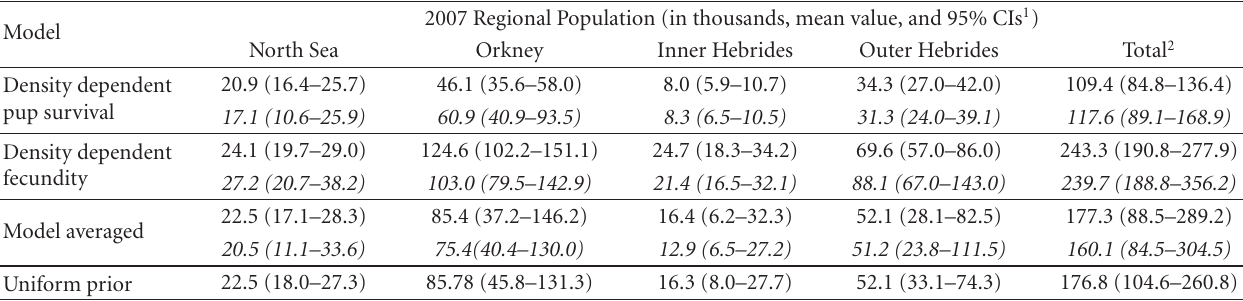
Table 2: Estimates (mean and 95% credibility intervals) of the total size of the grey seal populations in each region before breeding in 2007. The results for the two models are given along with those from simple (equally weighted) model averaging and applying the uniform prior across the two models. The numbers in italics are the equivalent estimates calculated from the best fitting state space models contained in the 2008 report of the UK Standing committee on Seals